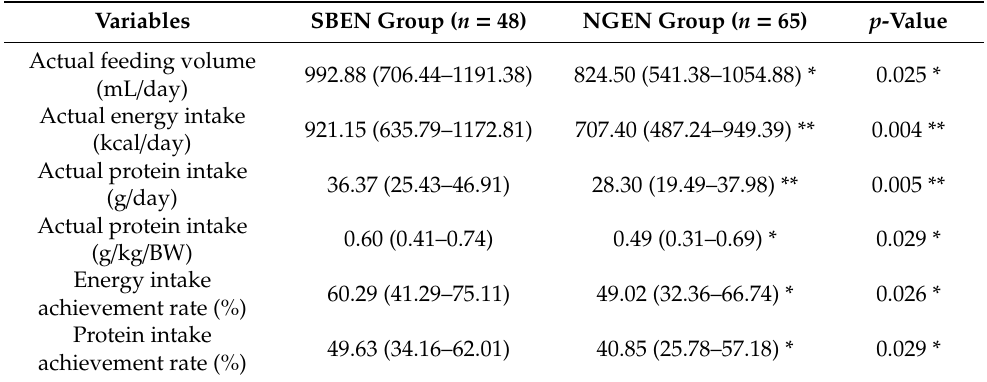
Table 2. Comparison of feeding e ffi ciency between SBEN and NGEN groups on the third day after enrollment in malnourished, critically ill, ICU patients.